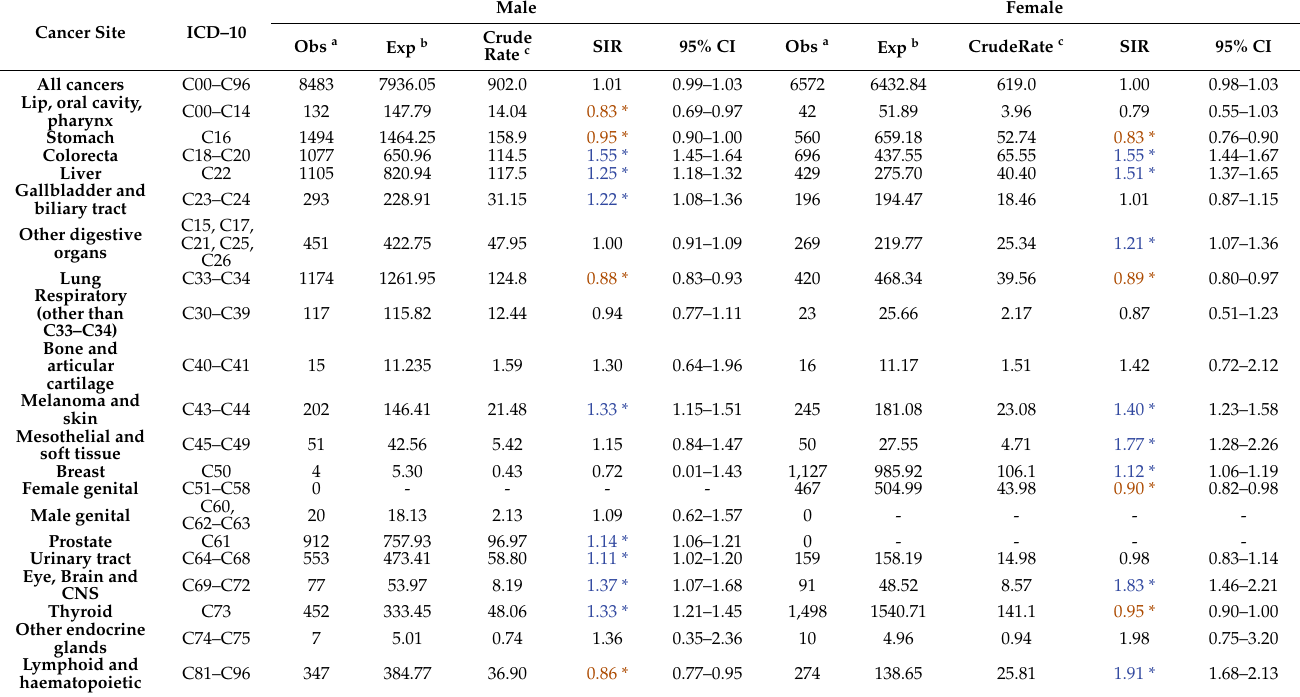
Table 2. Site-specific cancer incidence after cholecystectomy compared with that in the general population according to